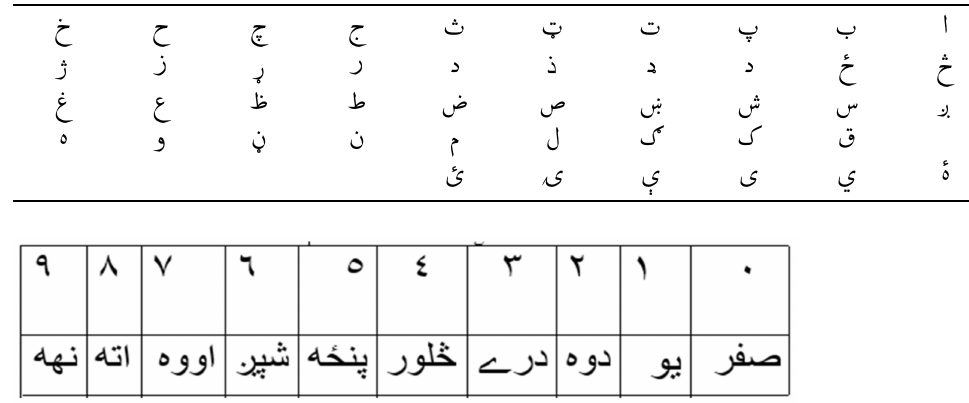
Figure 4. Complete Pashto Digits.